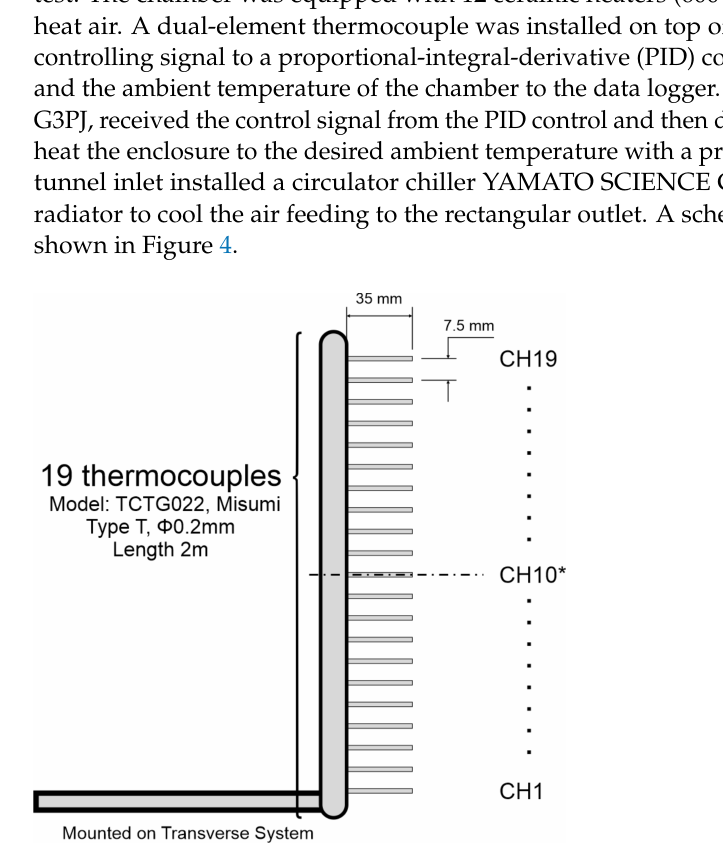
Figure 3. The thermocouple array consists of 19 thermocouples used to measure the temperature of flow. CH10* was located in the middle of the